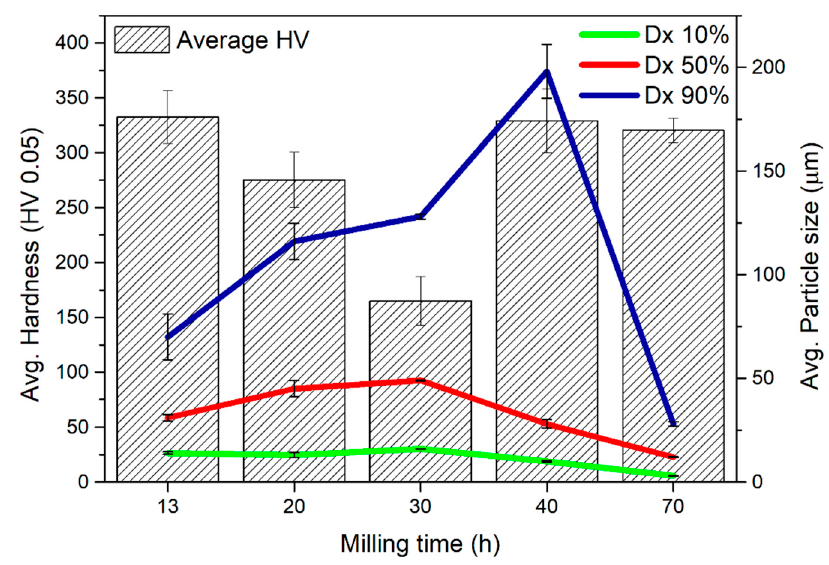
Figure 4. Graph representing average hardness values, as well as particle size, for Mg 65 Zn 30 Ca 4 Gd 1 powder alloy samples milled for 13, 20, 30, 40, and 70 h, respectively.